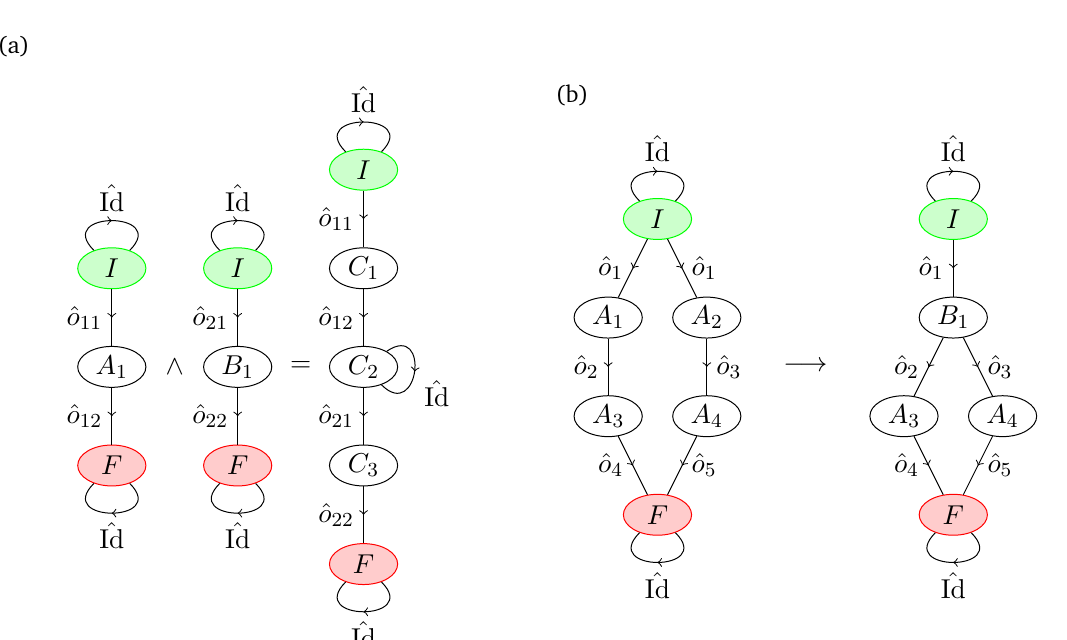
) ∧ Λ ( ˆ H ) for 2-point 2-ranged interacting ν 2 , r 2 , r 1 ) ⊕ Λ ( ˆ o ) to reduce the total ˆ o ˆ o ˆ o ˆ o 1 2 4 1 3 5